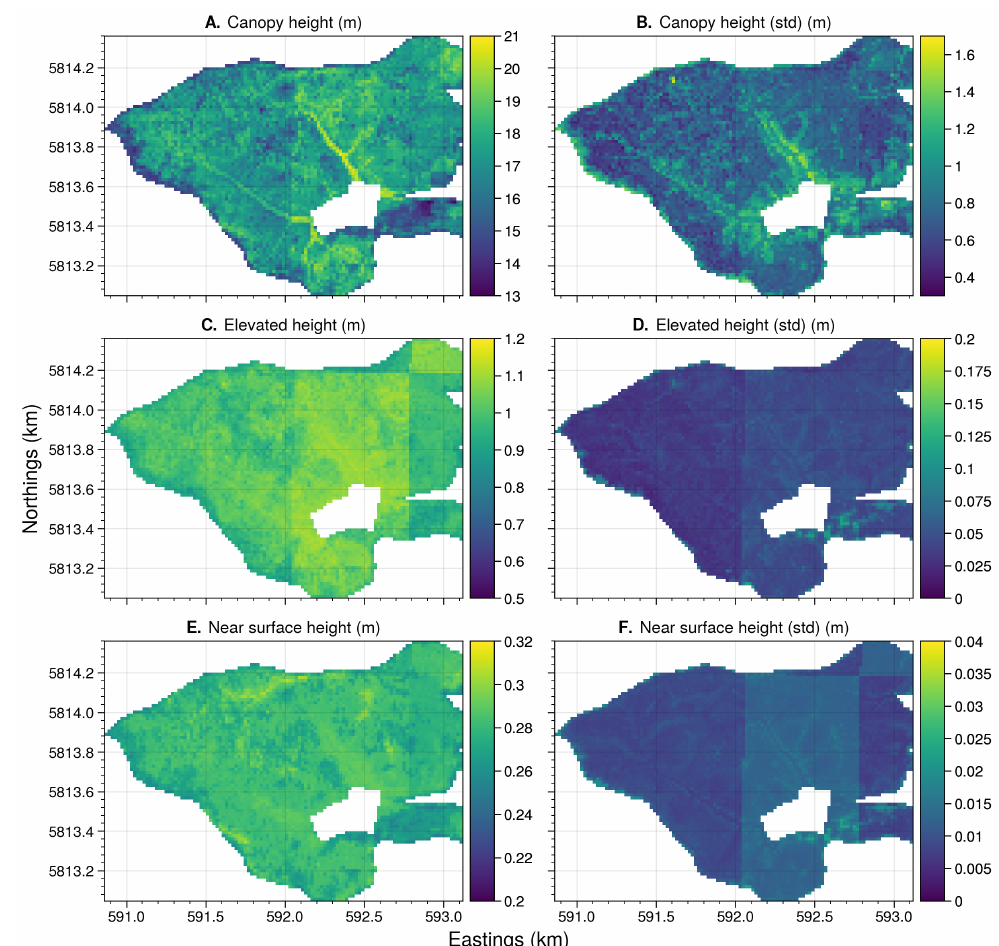
Figure A9. The mean and standard deviation predictions at landscape level for canopy ( A , B ), elevated ( C , D ), and near-surface ( E , F ) fuel height using TLS observations at Toorloo